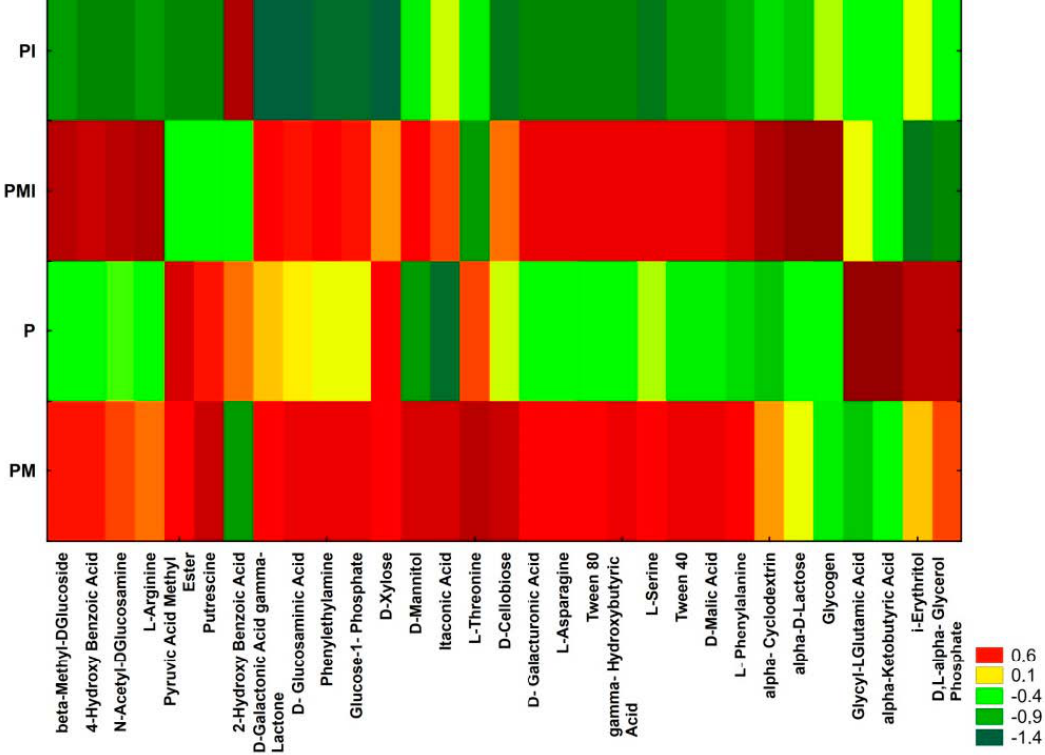
Figure 5. The carbon utilization patterns (31 substrates) in the soil samples. The results are shown as the standardized data of the absorbance measurements at a wavelength of 590 nm after a 96-h incubation of EcoPlates (red—higher functional activity and green—lower functional activity). Table 4. Functional diversity indices evaluated based on substrate utilization after 96 h in Biolog EcoPlates calculated for the data from all 31 carbon sources ( ± SD). Di ff erent letters indicate significant di ff erences between the cultivars ( p ≤ 0.05, n =